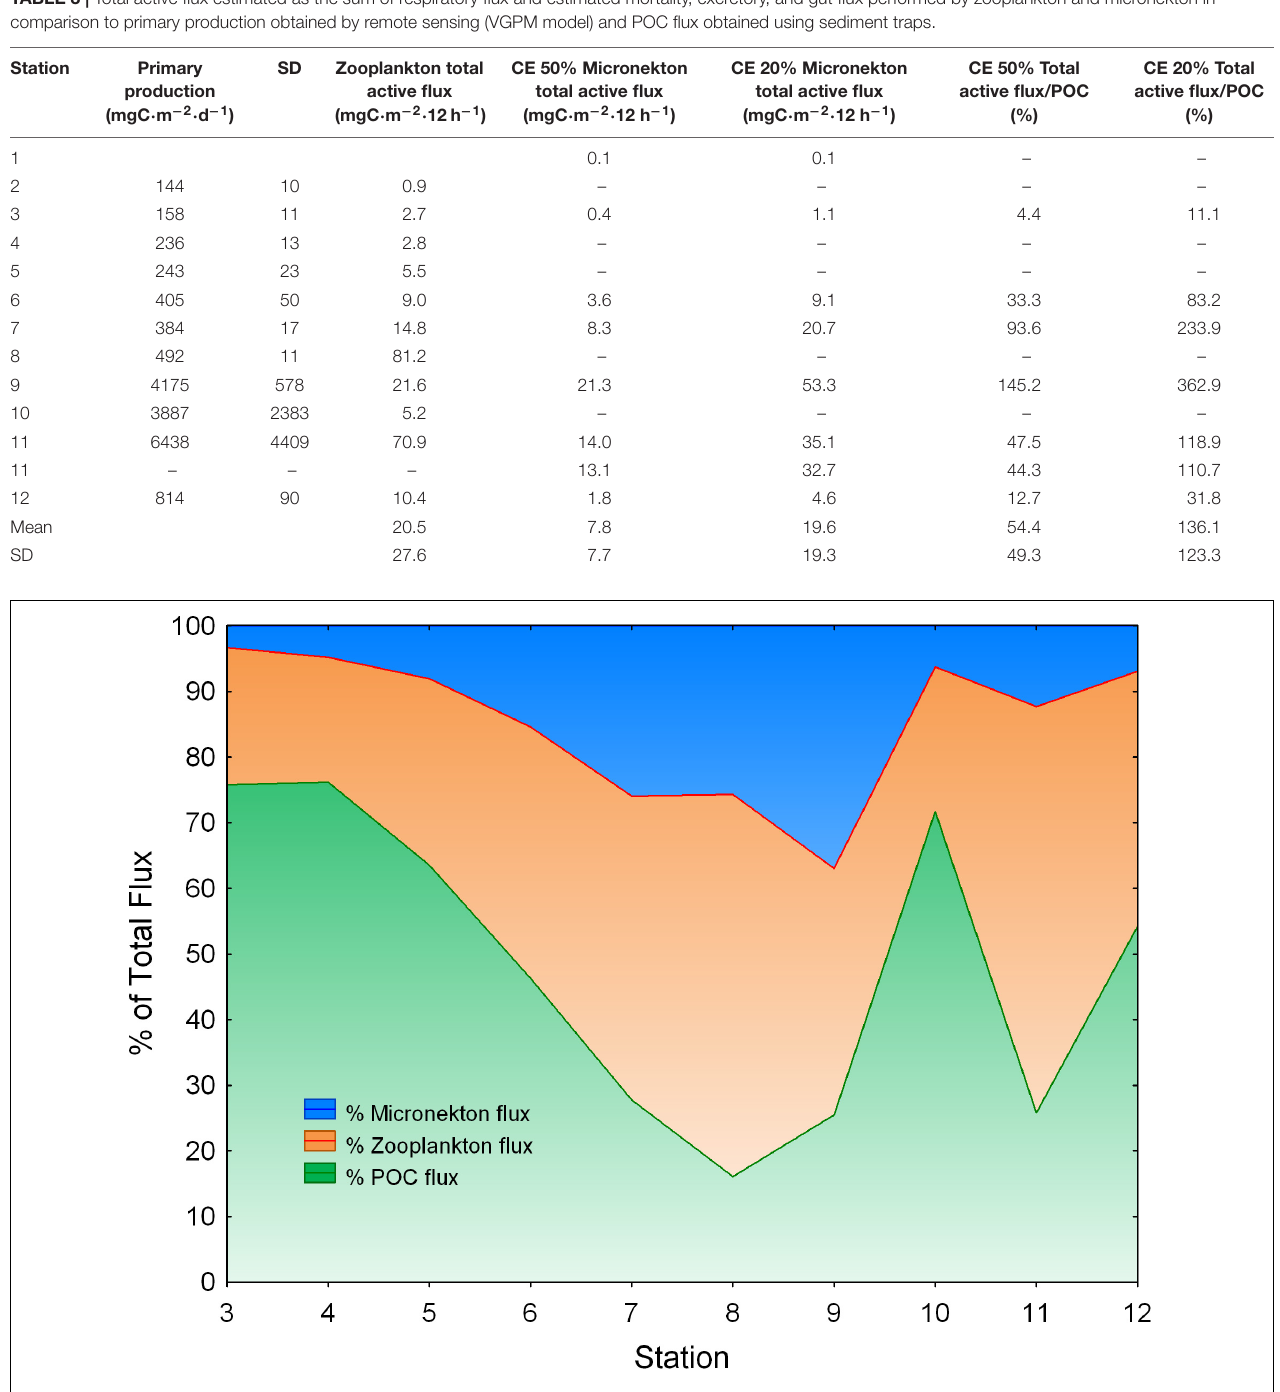
FIGURE 10 | Percentage of POC flux (lower), zooplankton active flux (middle), and micronekton flux using a 50% capture efficiency for the Mesopelagos trawl (upper). Observe the decreasing percentage of POC flux as productivity increases. Micronekton active flux for stations 4, 5, 8, and 10 were estimated from zooplankton active flux (see